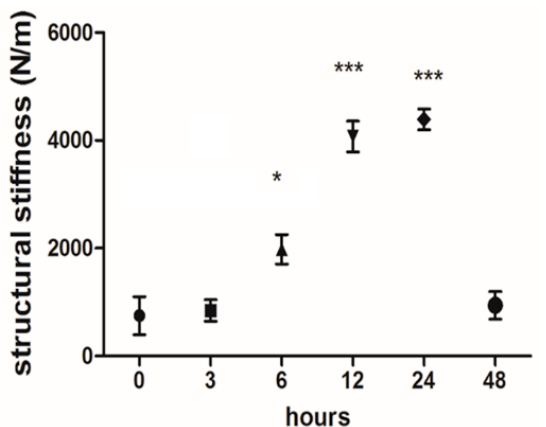
Figure 6. Real-time structural stiffness monitoring during cultivation of the tendon. The average structural stiffness of the samples was plotted during the application of cyclic uniaxial mechanical stimulation. The graph shows the mean stiffness values (forces/elongation) measured at each time interval. The structural reaction force of the tendon tissues after 6 h was significantly higher than at the beginning (1981 ± 272 N/m vs. 755 ± 354 N/m). This trend continues to increase through 12 and 24 h (4.074 ± 285 N/m and 4.391 ± 192 N/m, respectively). The measured force and, therefore, the stiffness, declined in the latter half of the cultivation (941 ± 255 N/m at 48 h). *: p ≤ 0.05 and ***: p ≤ 0.001.